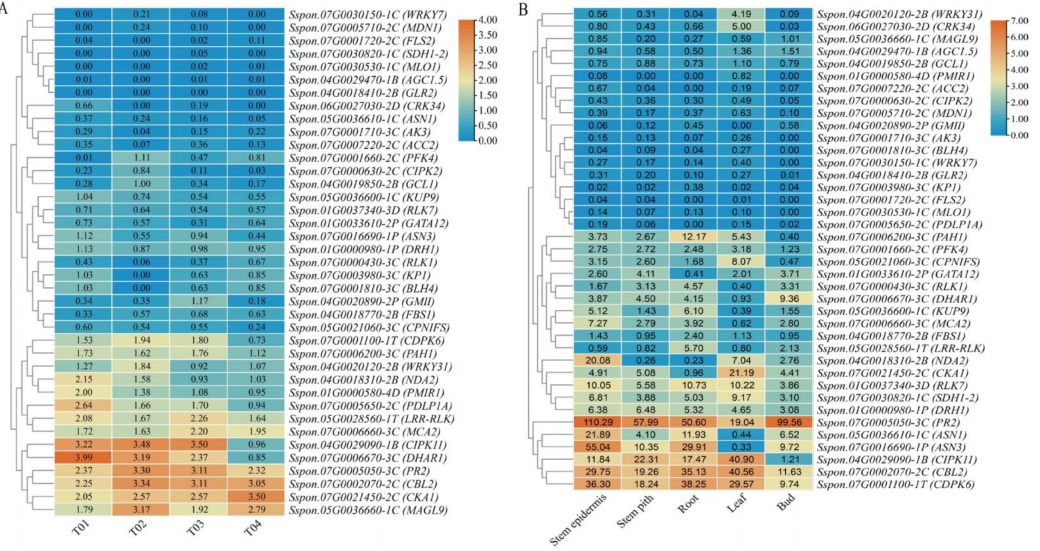
Figure 5. Expression profiles of the candidate genes. ( A ) Expression patterns of 39 candidate genes in four sequenced samples. ( B ) Expression patterns of 39 candidate genes in different tissues of sugarcane parent ROC22. Heatmaps are generated based on FPKM values using TBtools. The color scale represents the range of FPKM values, in which orange and blue represent high- and low-level expression,